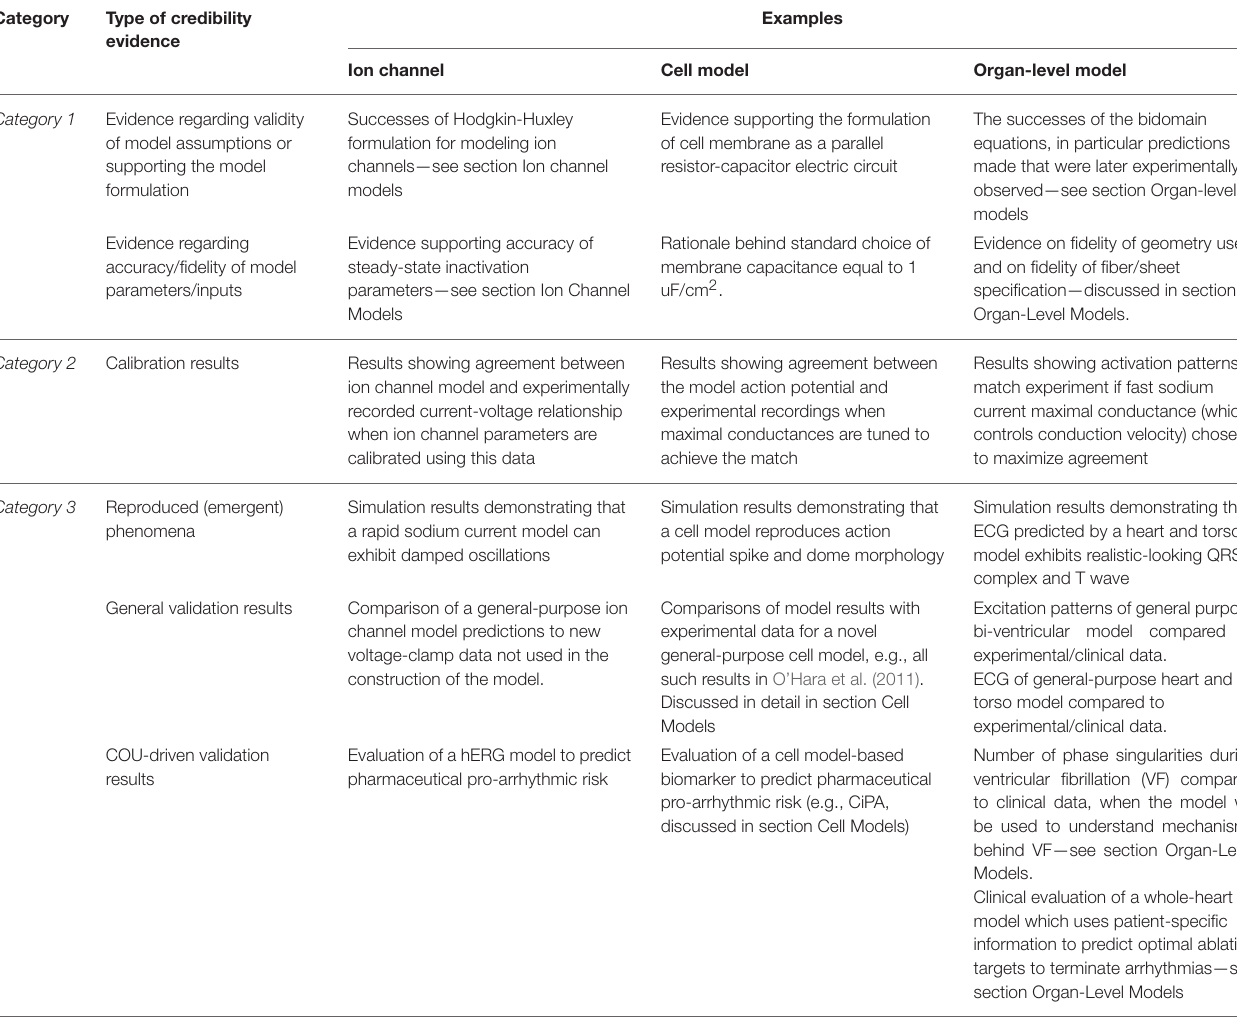
TABLE 1 | Different types of evidence relevant to the credibility of a cardiac EP model, with ion channel, cell, and organ-level